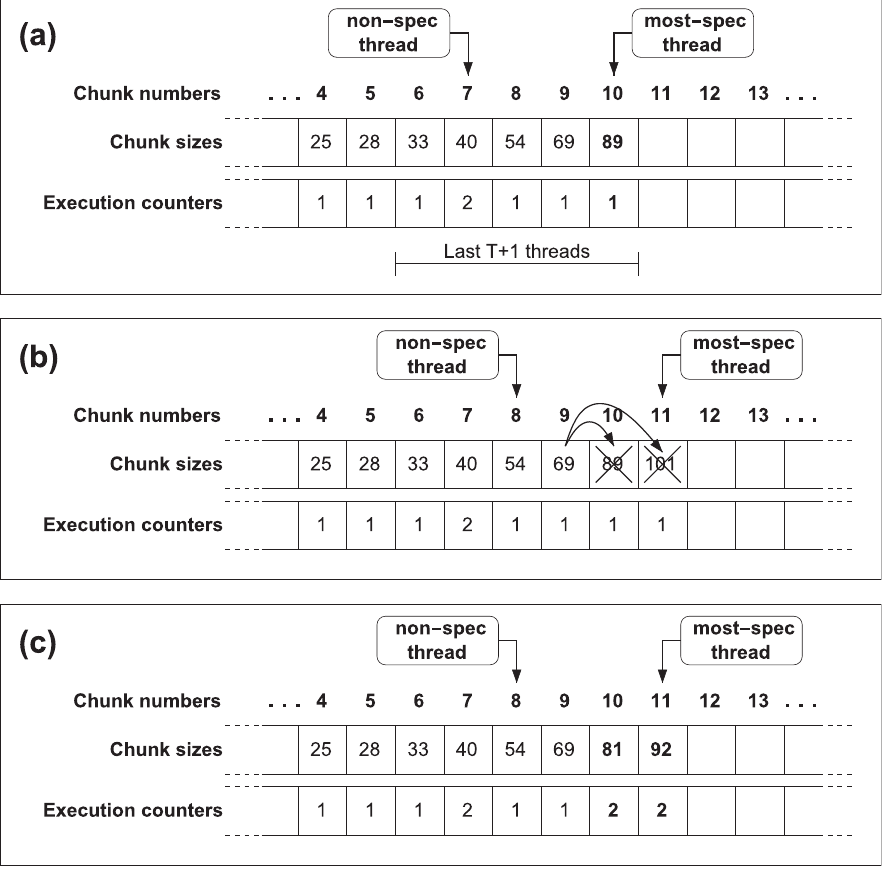
Fig 3. JIT scheduling, adaptive approach. (a) Size of chunk 10 is calculated using the JIT scheduling function. (b) Chunk 9 issues a squash operation. (c) Squashed threads recalculate in program order the size of the chunk to be executed, using the new value of the execution